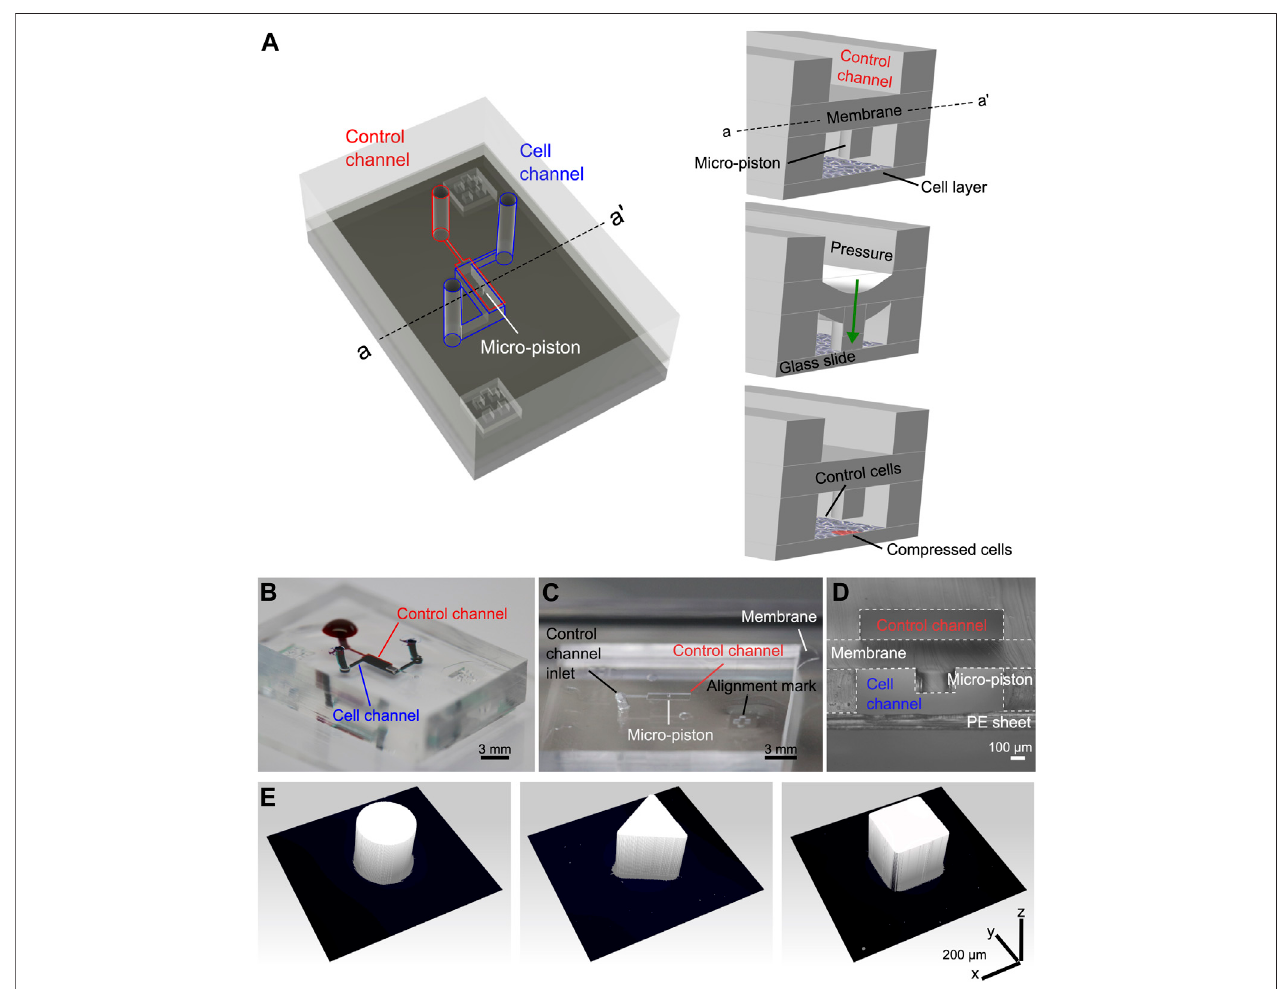
FIGURE1| Devicedesign,conceptofcompression on cells, and fabricated devices. (A) Assembly design ofthe chipcomposed ofthecontrolchannel(outlined in red)forintroducinggaspressureandcellchannel(outlinedinblue)forcellculture.Theconceptofapplyingcompressiononcellsisillustratedbythemembranede fl ection and micro-piston brought onto the cells by the pressure applied through the control channel and retracted back after compression. Thus, the localized part of the cell monolayerunderthemicro-pistonwascompressed,whiletherestactedascontrol(Figurenotdrawntoscale). (B) TopviewofthePDMSlayersofthemicro-piston device (scale 3 mm). The devices were vacuumed for 3 h, and channels were passively fi lled with dye solutions for visualization. (C) Top view of the PDMS micro-piston with the membrane bonded to control layer before bonding to bottom open channels (scale 3 mm). (D) Cross-sectional view of the micro-piston device (scale 100 µm). (E) 3D pro fi lometer scans of circular, triangle, and square micro-pistons sitting on PDMS membranes bonded to control channel layers as in (C) ( x – y – z scale 200 µm